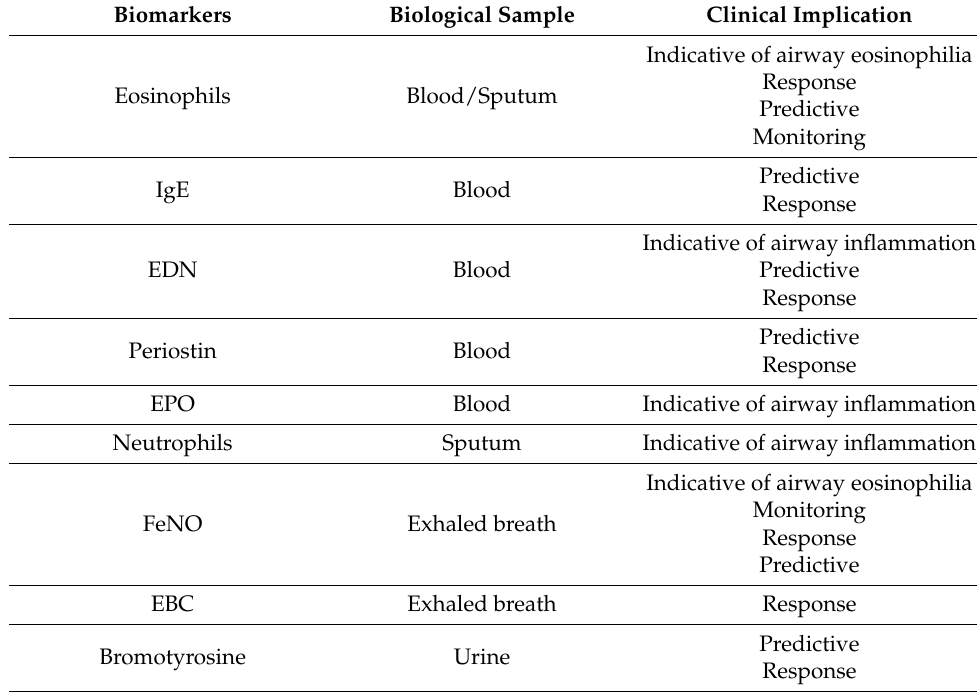
Table 2. Biomarkers of severe eosinophilic asthma and their clinical